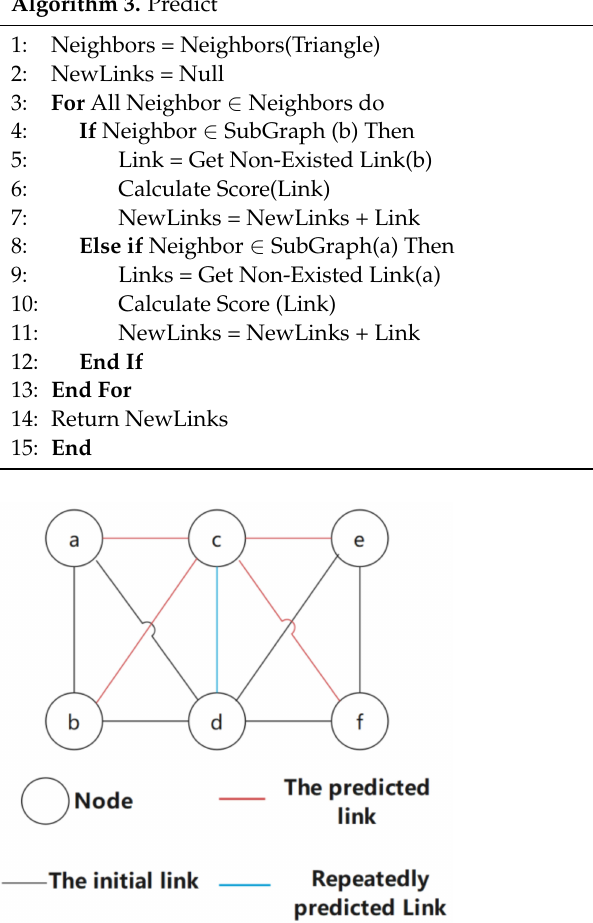
Algorithm 3. Predict